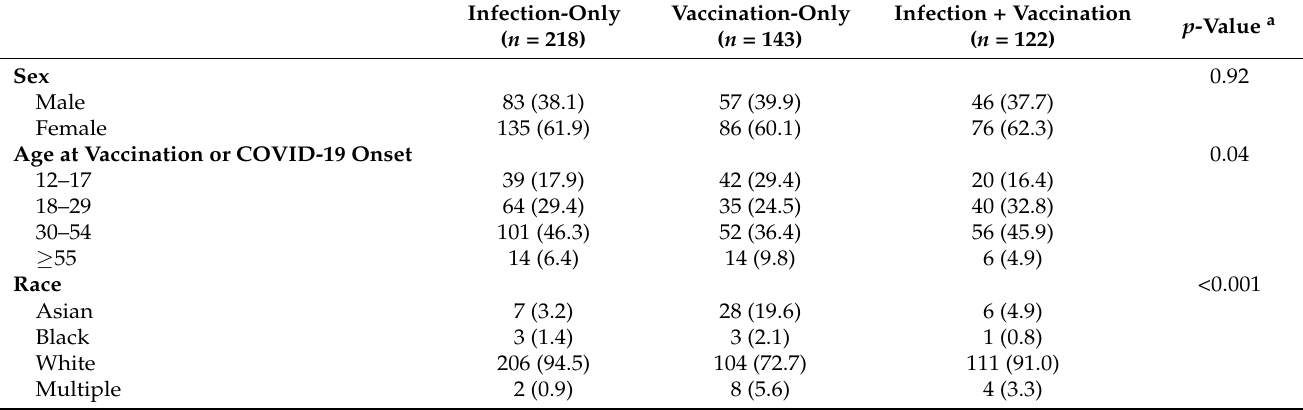
Table 1. Participant demographics and clinical